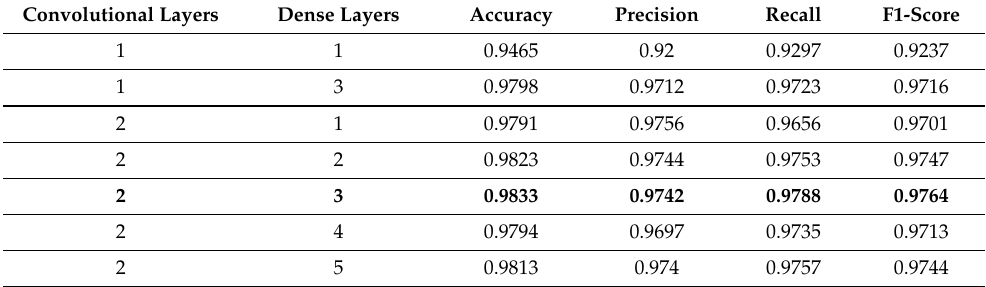
Table 4. A comparison of CNN layers for multi-class category classification.